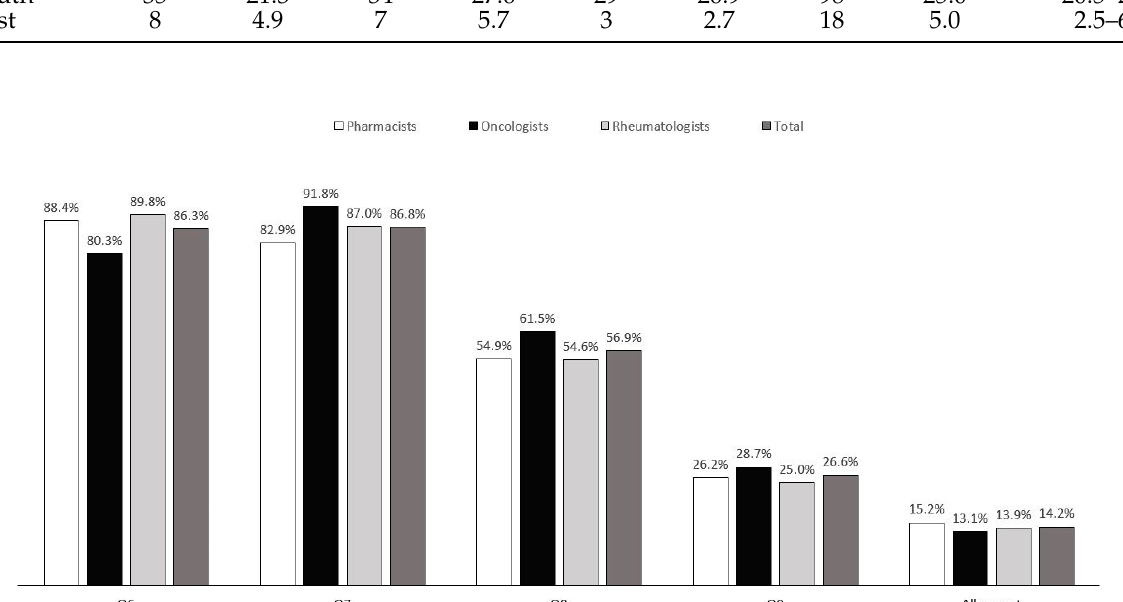
Table 2). Of the five demographic characteristics (gender, region, profession, age groups, and hospital type), only hospital type showed a significant association with the respond- ents’ knowledge scores. A greater proportion of respondents from medical centers (20.8%)